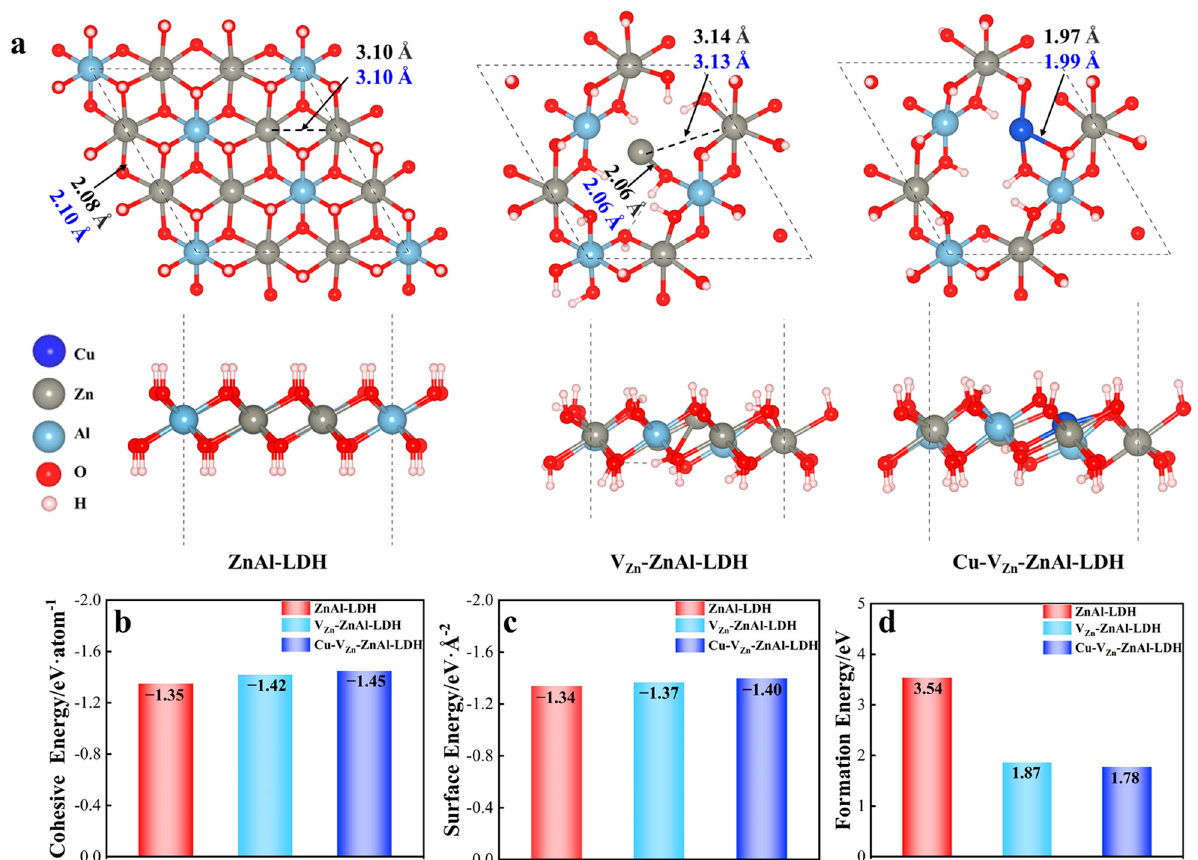
Figure 2. ( a ) Key geometrical parameters of three ZnAl-LDHs with DFT values in black and exper- imental values in blue. The stability is measured by ( b ) cohesive energy, ( c ) surface energy, and ( d ) formation energy.